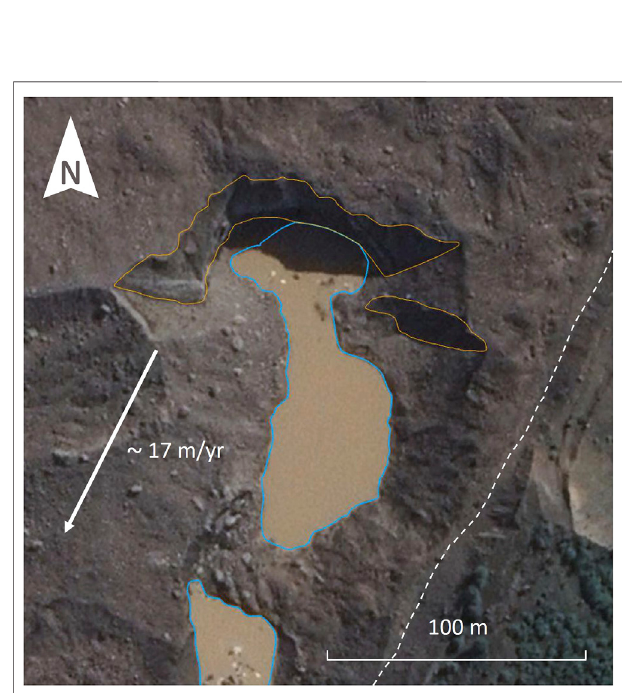
FIGURE4| Outlinesofmappedponds(solidbluelines)andsouth-facing ice cliffs (solid orange lines), from march 4, 2018. White arrow indicates local mean surface velocity, extracted from spline interpolation surface. White dashed line shows the glacier outline.